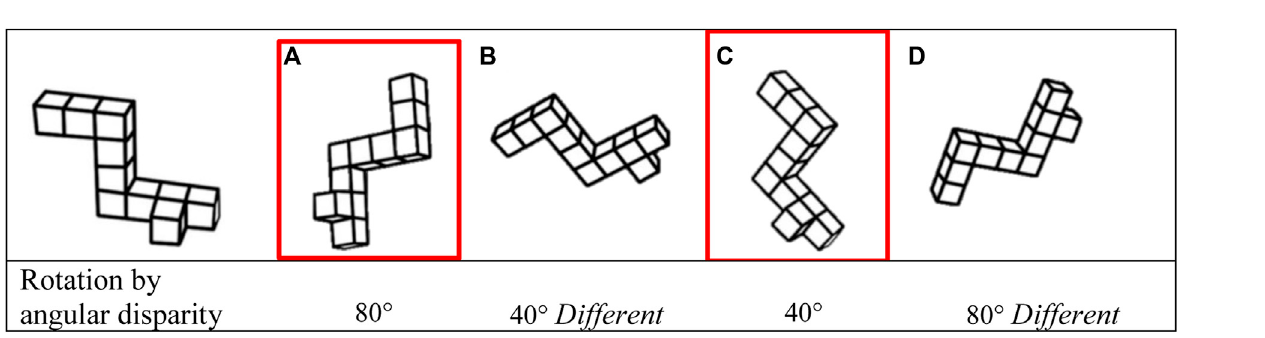
TABLE 2 | An example Pentomino-MRT item representing the combination and allocation (Different, Rotation, and small angular disparities of 40 ° and 80 ° ).